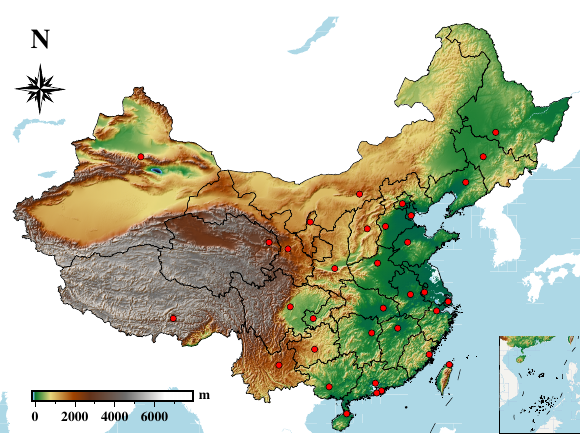
Figure 1. The sites (red points) of Chinese cities for IS extracting experiments in the height map.